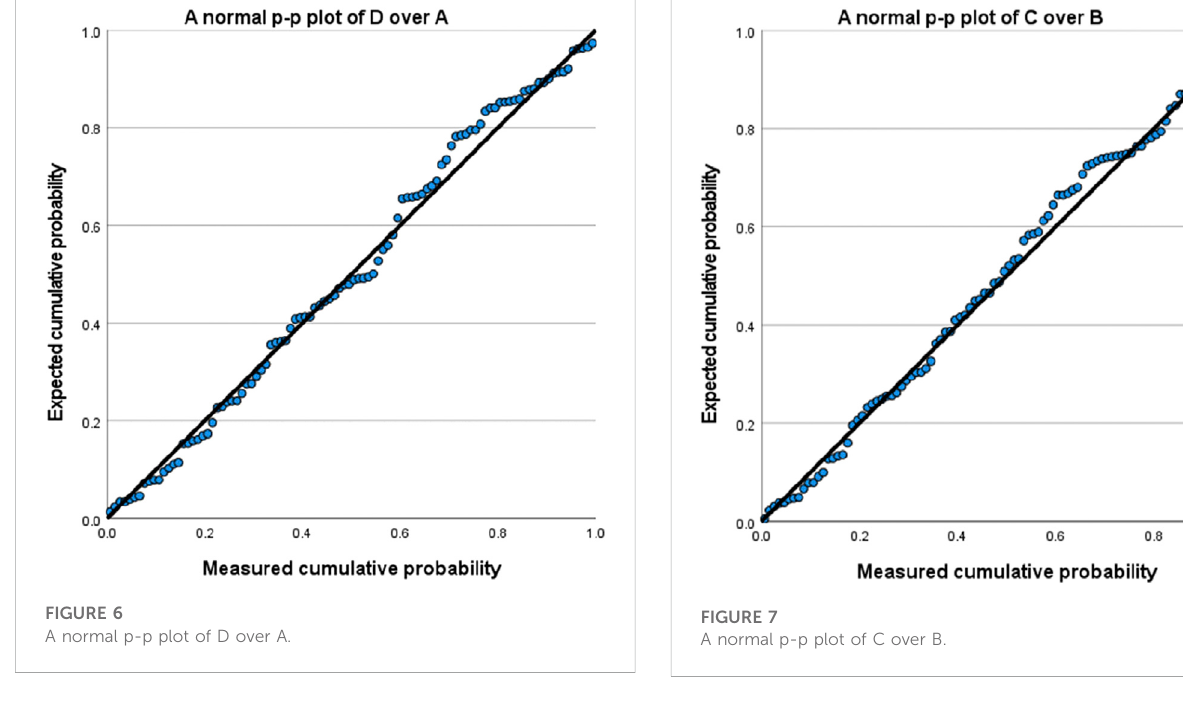
FIGURE 6 A normal p-p plot of D over A.